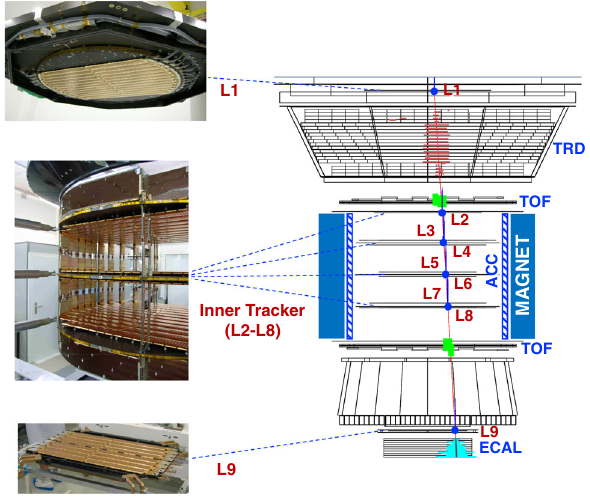
Fig. 1 (Right) Schematic view of a cosmic-ray fluorine nuclei event of 26 GV rigidity measured by AMS, with the signals in the TRD, TOF, silicontracker,RICH,andECAL.Alsoshownarethepermanentmagnet and ACC. (Left) Layout of the tracker showing the upper external layer (L1), the inner tracker (L2–L8), and the lower external layer (L9) as well as their support